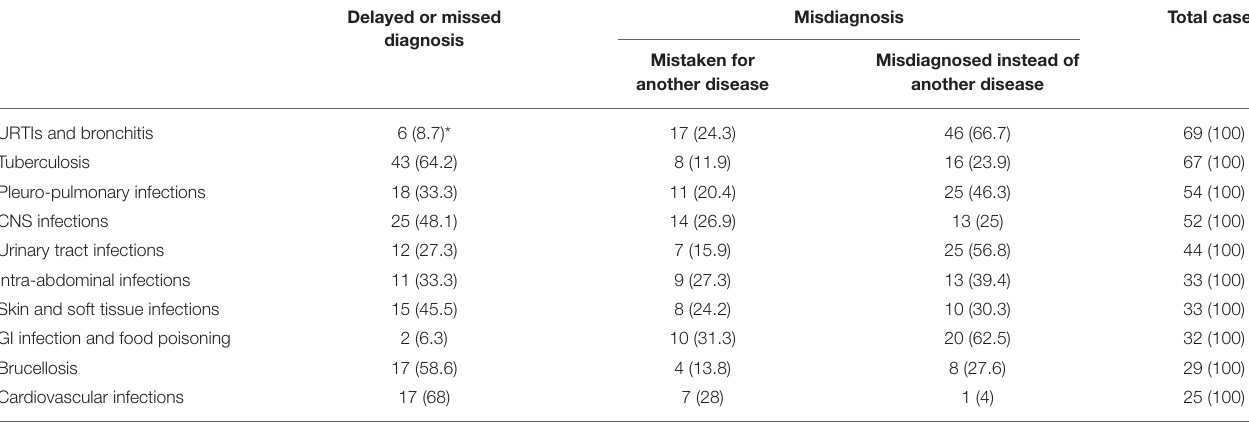
TABLE 3 | Frequency of delayed or missed diagnoses, and misdiagnoses in the categories of infectious diseases that were most frequently affected by errors.